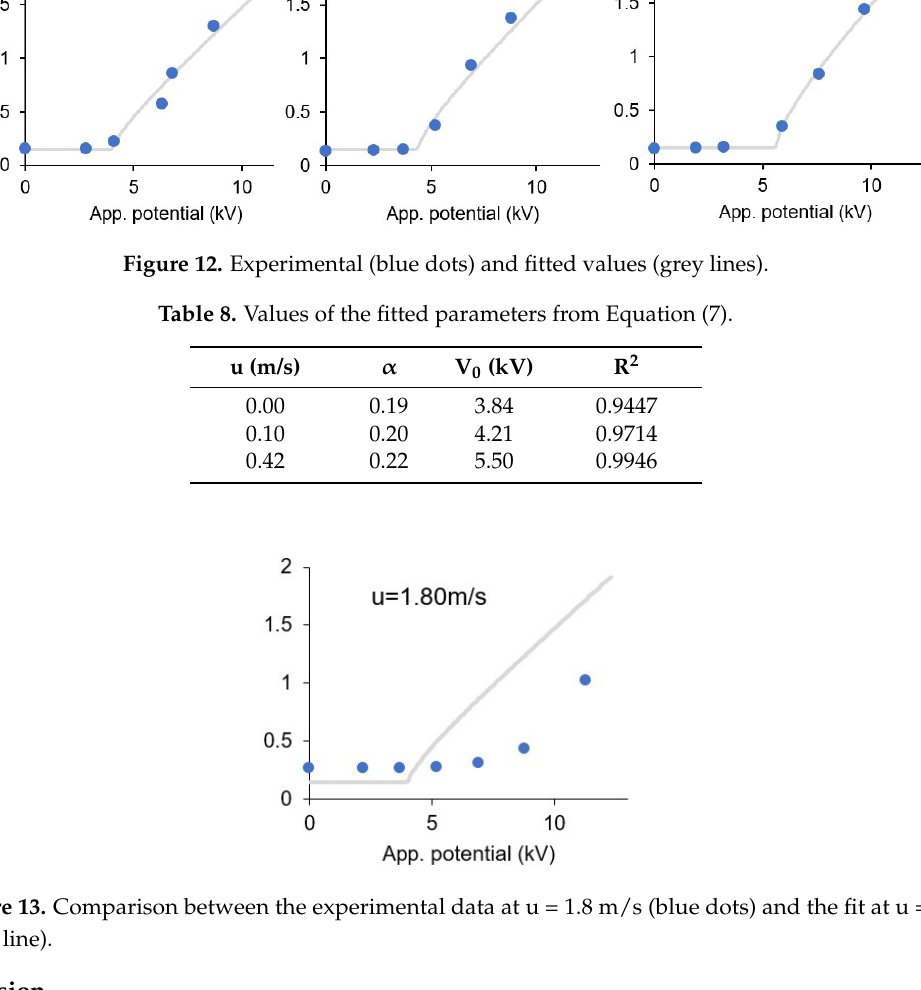
Table 8. Values of the fitted parameters from Equation (7).